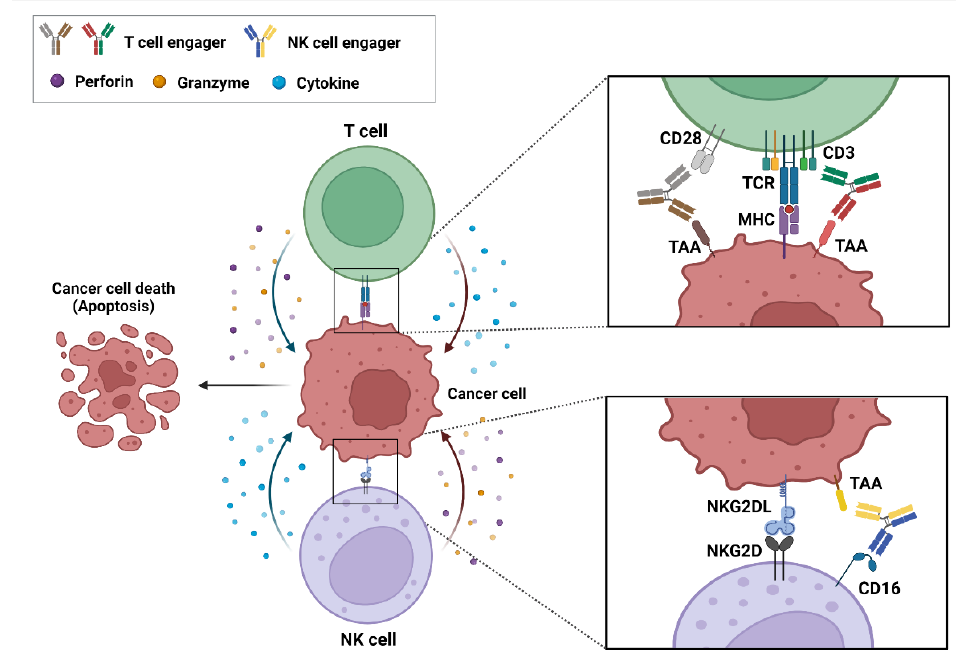
Figure 1. Action mechanism of bispecific antibody (bsAb)-based immune-cell engagers (ICEs) in cancers. The schematic drawing represents bsAb-based ICEs, including T- and natural killer-cell engagers, that bind simultaneously to tumor-associated antigens on cancer cells and specific antigens, such as CD3, CD28, and CD16 on immune cells. These interactions result in the formation of an immune synapse and the activation of immune cells that release cytokines, perforins, and granzymes to induce the cytotoxic effects on cancer cells.